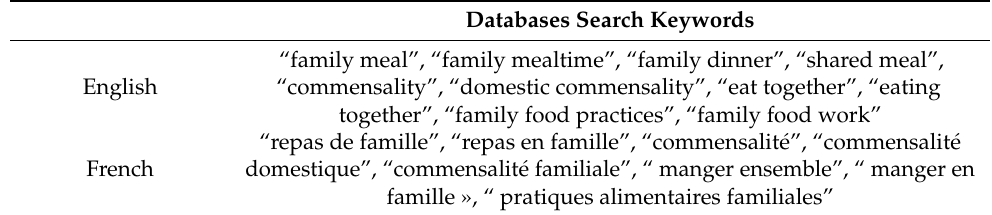
Table 1. Keywords used for the databases searches.